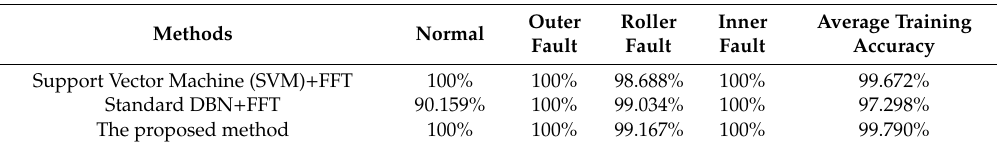
Table 8. Training accuracy results of various methods.